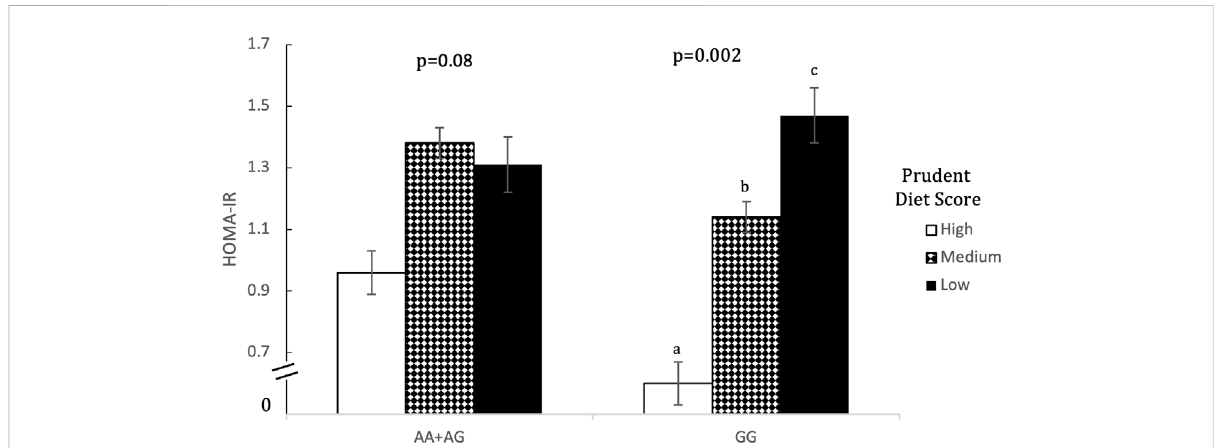
FIGURE 1 Homeostatic model assessment of insulin resistant (HOMA-IR) by Prudent Dietary Score and 9p21 genotype (rs10757274). Data are means ± SEM. Statistical signi fi cance was calculated using unadjusted ANOVA initially for the interaction term of gene-diet in all six groups ( n = 1309, p = 0.031), and then separately for prudent dietary score in those with the AA or AG genotype ( n = 985, p = 0.076) and those with the GG genotype separately( n =324, p =0.002).IntheGGgroup,thosewithhigh(75thpercentile)andmedium(26th-74thpercentile)prudentdietaryscorehad a signi fi cantly lower HOMA-IR than those with low (25th percentile) prudent diet score ( p = 0.004 and p = 0.014 respectively). In the AA+ AG group HOMA-IR did not differ between any of the prudent dietary score groups. Different letters (a versus b) indicate pairwise differences between group means that were statistically